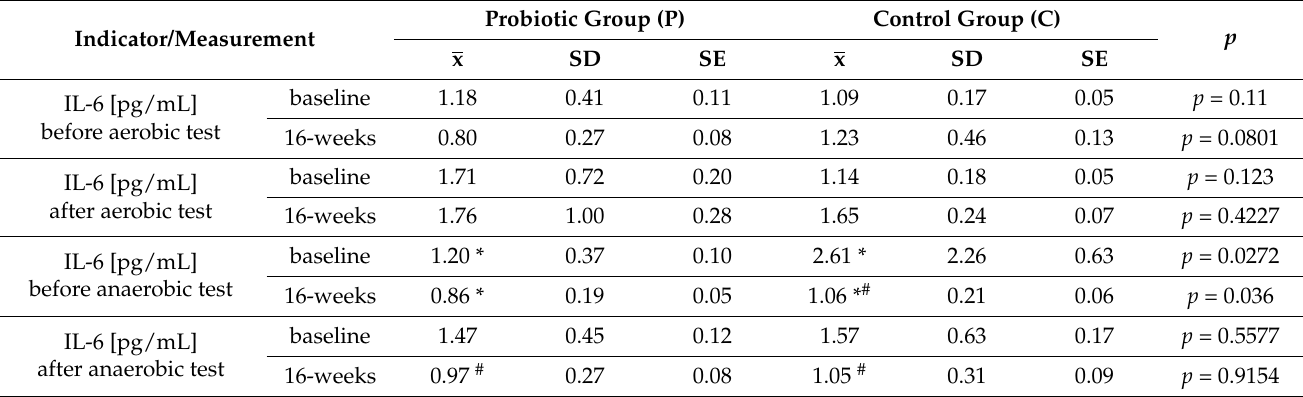
Table 10. The concentration of Interleukin 6 (IL-6) pre- and post-aerobic test and pre- and post- anaerobic test at follow-up measurements during supplementation intervention.